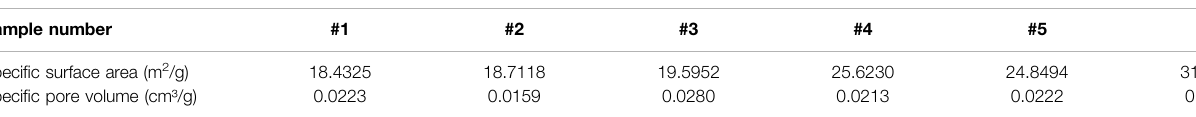
TABLE 4 | Comparison of surface area and pore volume of samples.